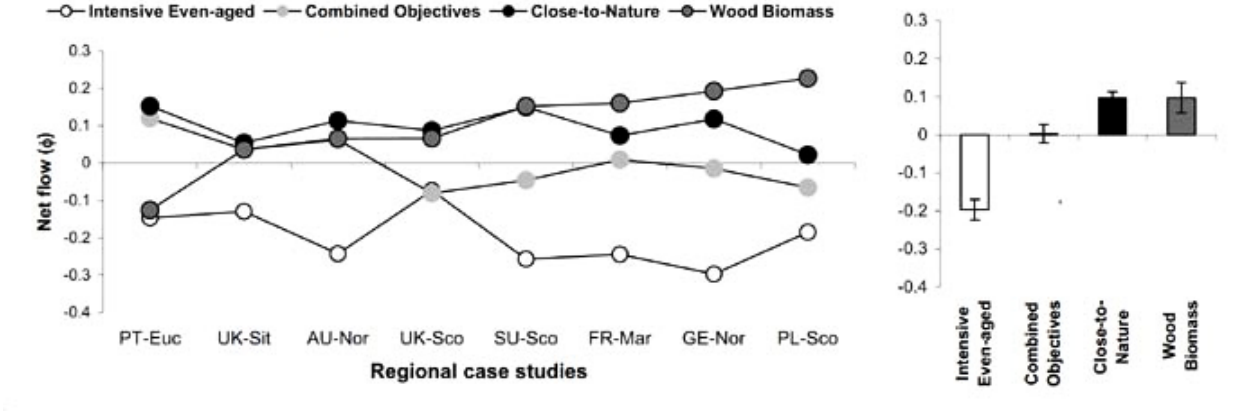
Fig. 2. Ranking of forest management alternatives (FMAs) according to impact on risk of biotic and abiotic damage across eight different regional case studies (left-hand side) and for overall results (right-hand side). FMAs with higher net flow ( F ) are preferred to those with lower net